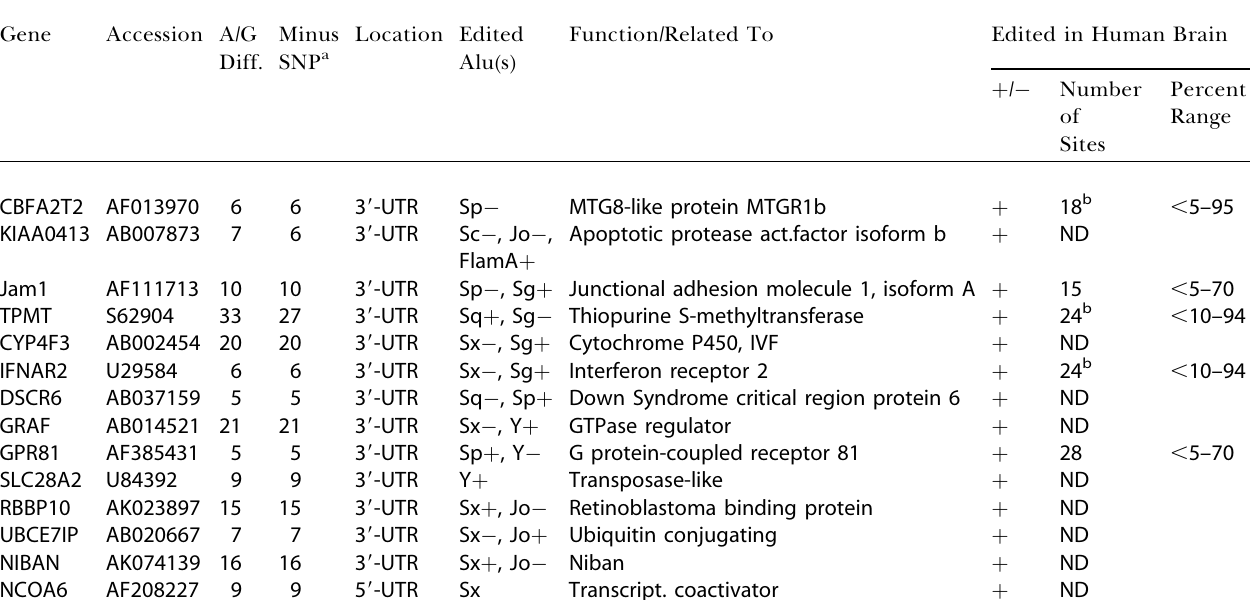
Table 2. Edited Alu Exons from Computational Screen for Alu Element Foldback Structures Gene Accession A/G